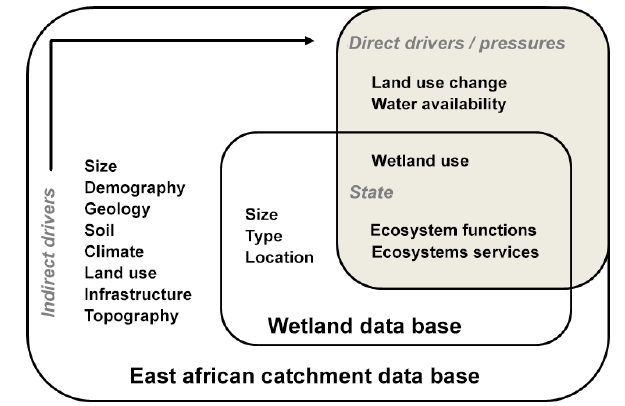
Figure 2. Conceptual model and data structure of the nested East African wetland-catchment data